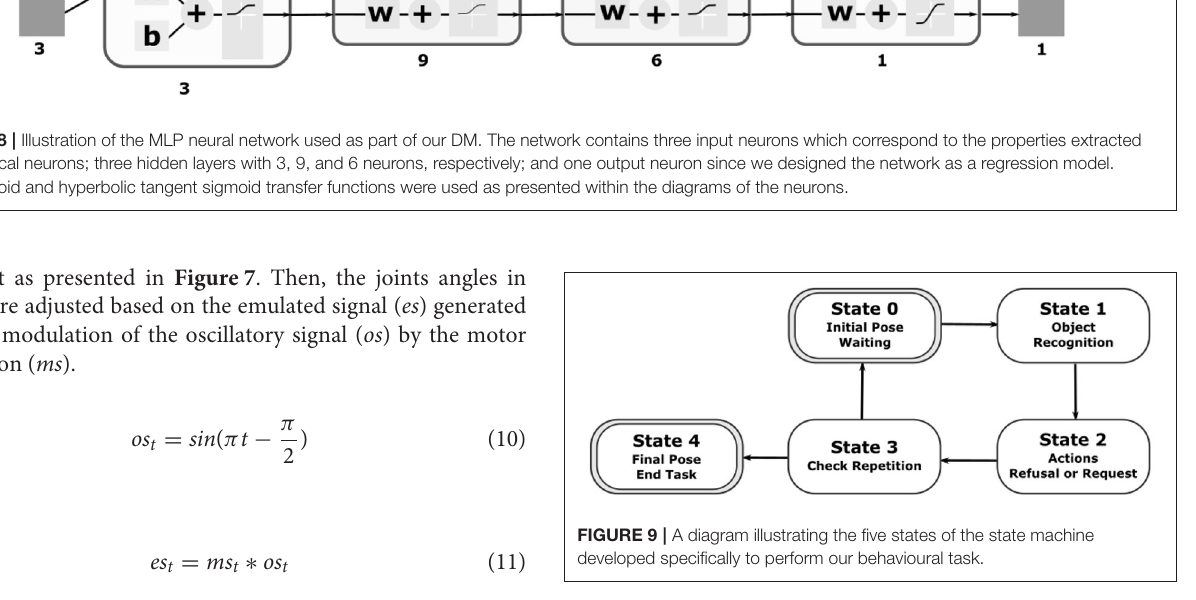
and asks someone to allocate one ball in front of him. Once a ball is detected, the state is updated to state 1. In this state,